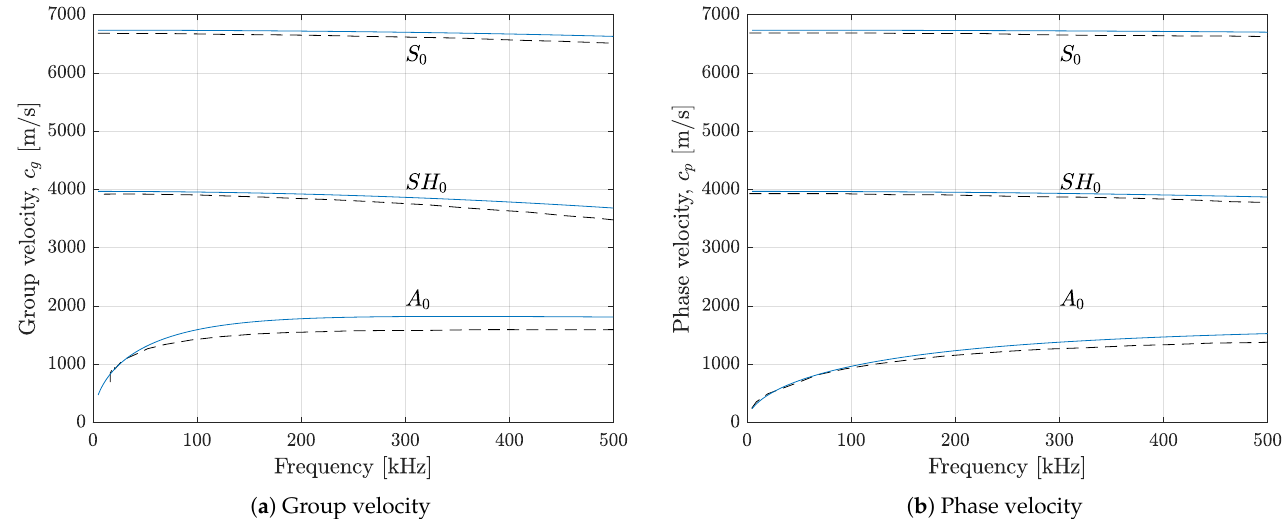
Figure 4. Dispersion curves along the principal direction 1 of 0 ◦ lamina for [+ 45/ − 45/0/90 ] s laminate obtained using the SAFE (- -) and WFE (–) methods.